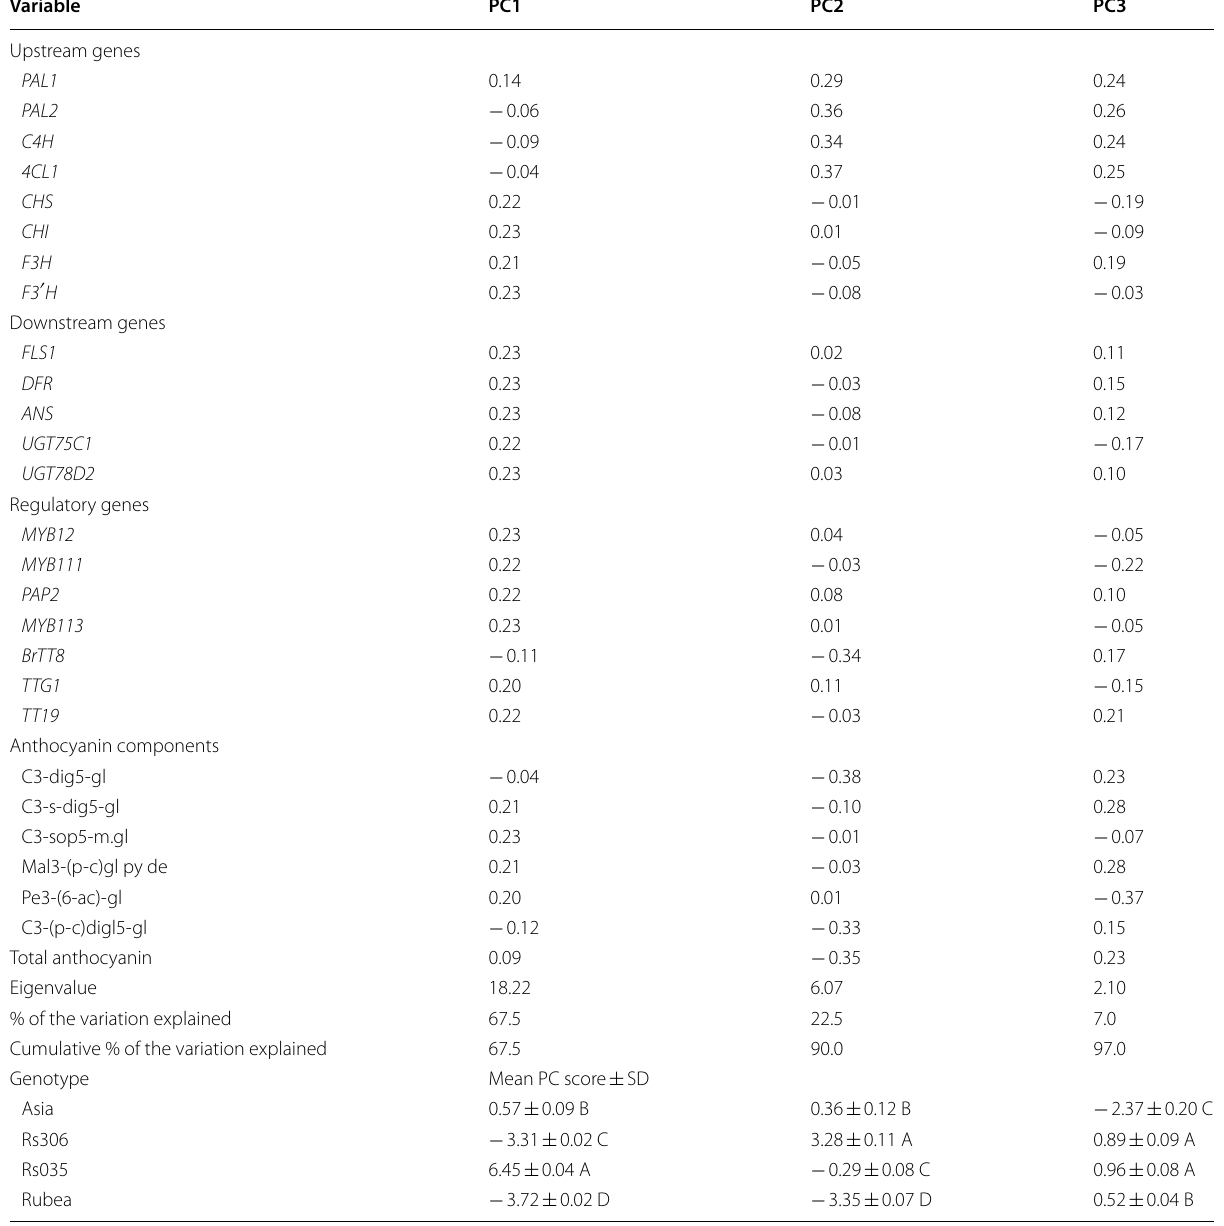
Table 2 Component loadings and mean principal component (PC) scores, showing the association between the total and constituent anthocyanin contents and the expression levels of the biosynthetic and regulatory genes, as determined using a principal component